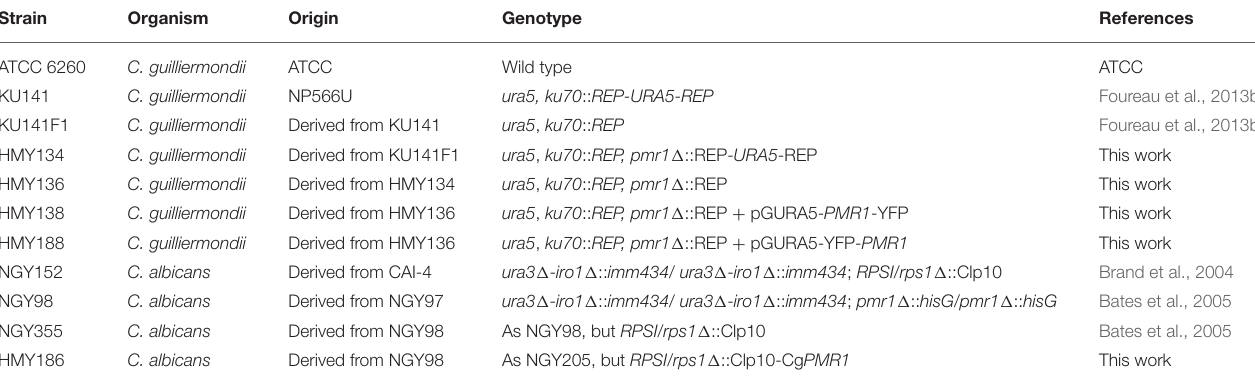
TABLE 2 | Strains used in this